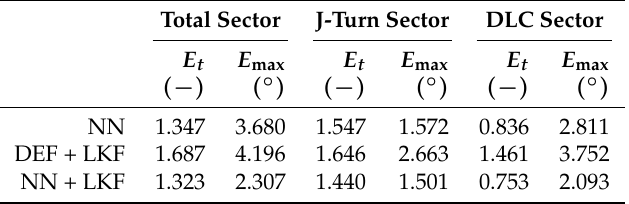
Table 7. Norm and maximum errors for roll angle estimators for J-turn and DLC